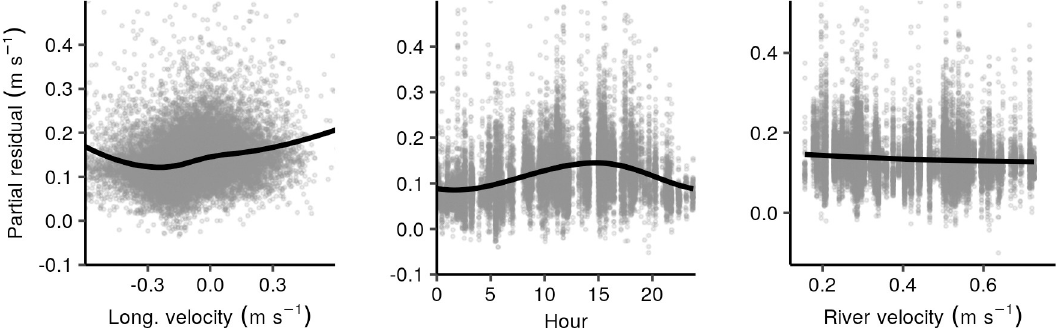
Fig 10. Summary of GAM for lateral swimming speed. Significant smooths (black line), and partial residuals (gray circles) for GAM of lateral swimming speed.